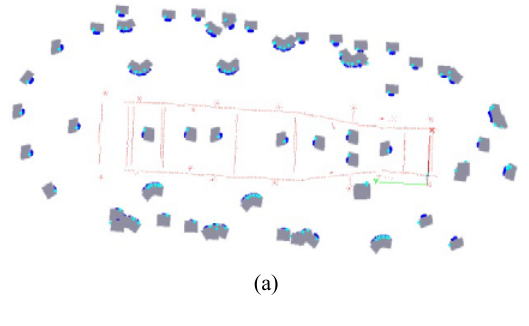
Figure 3. Network structure created for original chassis from top view(a), and side view (b)